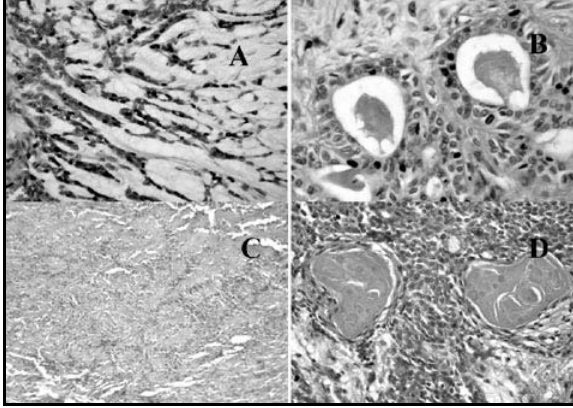
Figura 2 – A: Arranjo cordonal (HE, 400x); B: arranjo ductal (HE, 400x); C: paliçada (HE, 100x); D: metaplasia escamosa (HE,